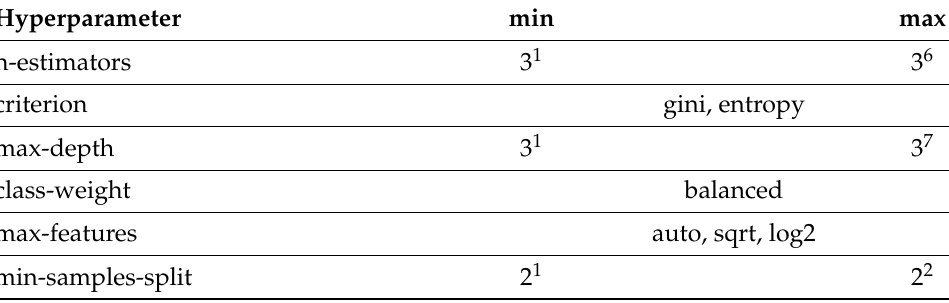
Table 4. Evaluated hyperparameters for the Random Forest.